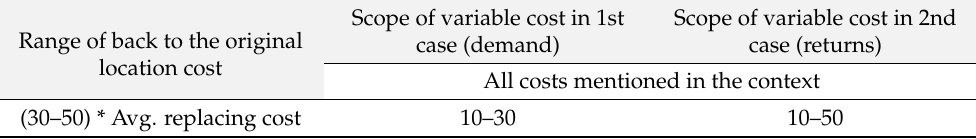
Table 16. The range of transported costs per unit